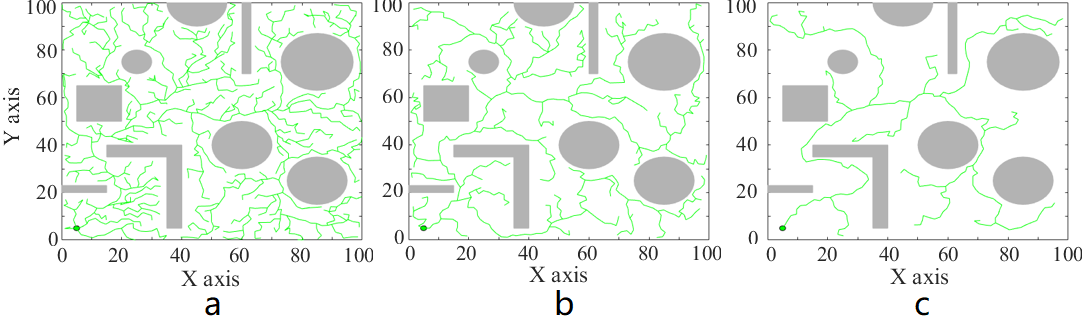
Figure 13. The effect of len on tree expansion (sample times = 4000, ( a ) len = 2, nodes num = 1086; ( b ) len = 4, nodes num = 498; ( c ) len = 6, nodes num = 301).